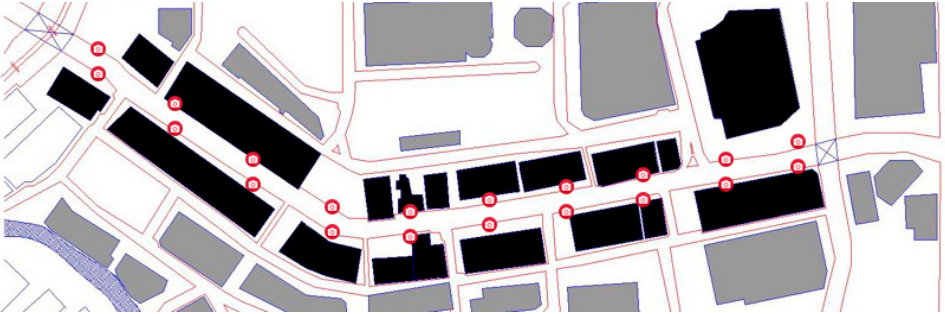
Figure 4. Locations of the collected pictures at JTAR before the sorting and elimination process.